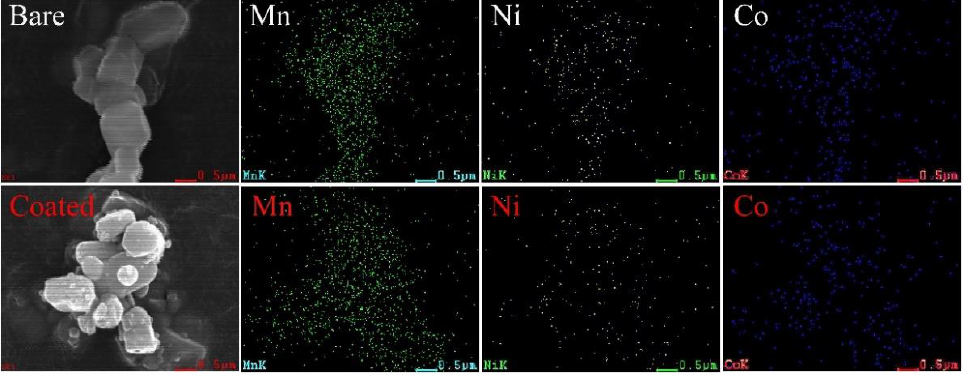
Figure 3. The elemental distributions of Mn, Ni, and Co in the bare and MnO 2 -coated LTMO particles. Table 2. The elemental composition of the bare and MnO 2 -coated LTMO determined with ICP-AES.